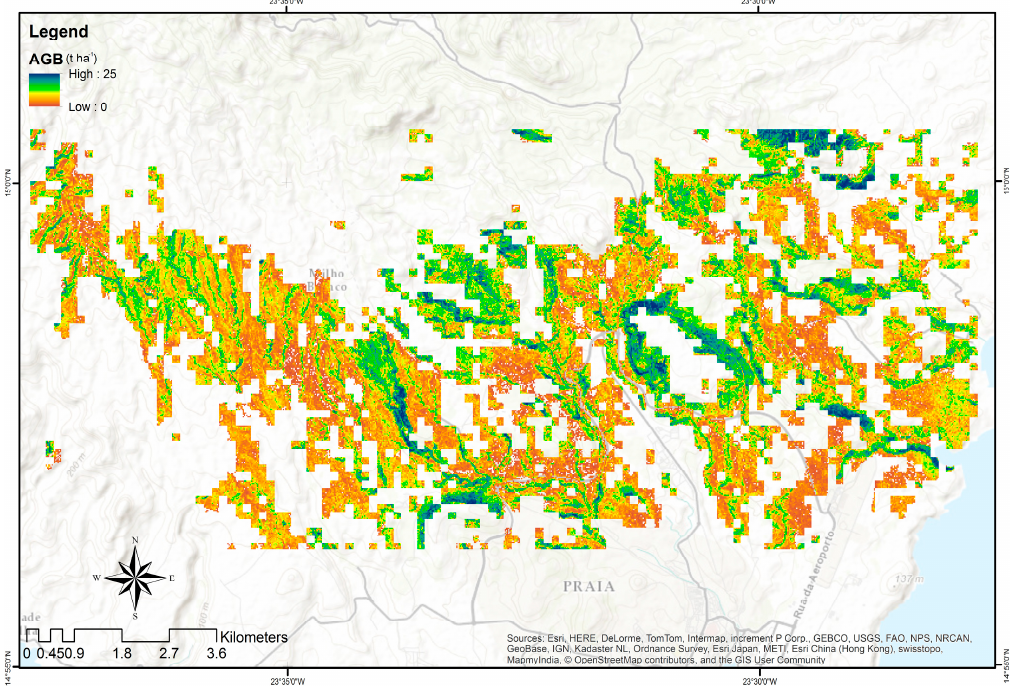
Figure 6. Final AGB map of the study area calculated on the basis of the area-based approach.